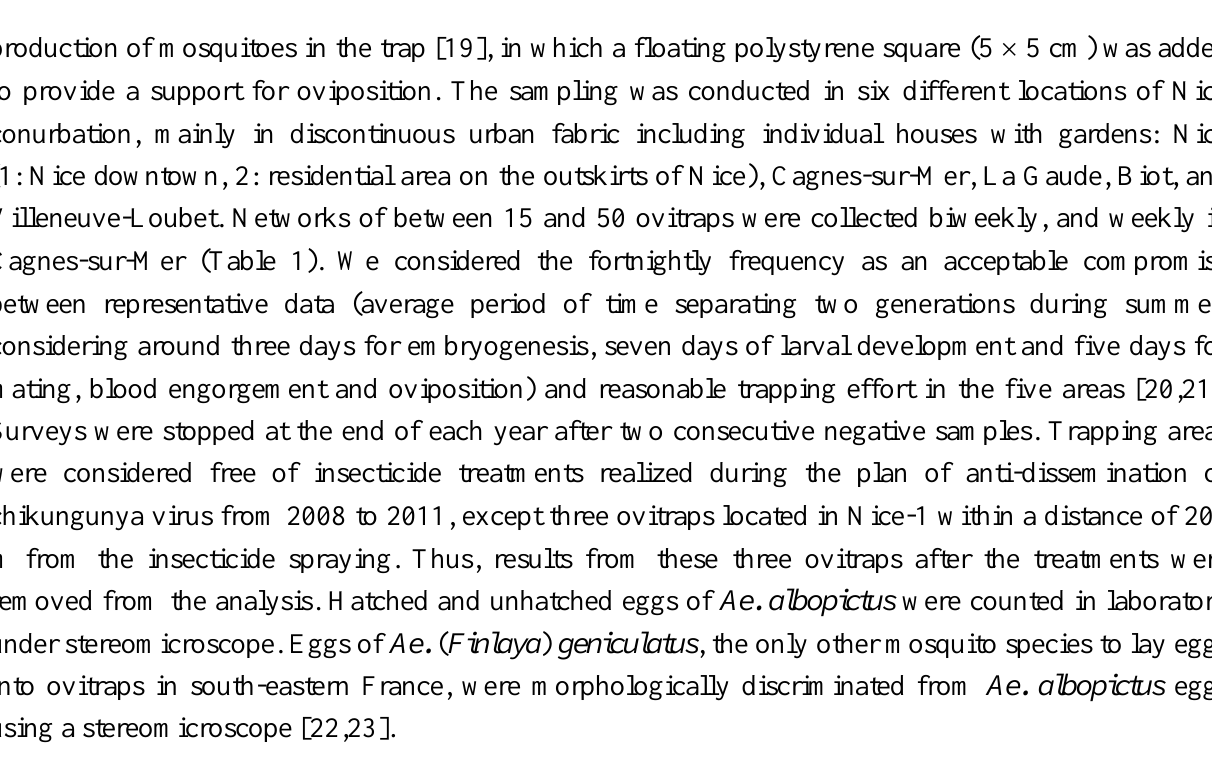
Table 1. Entomological collections for the surveillance of Aedes albopictus , Côte d’Azur area, France,